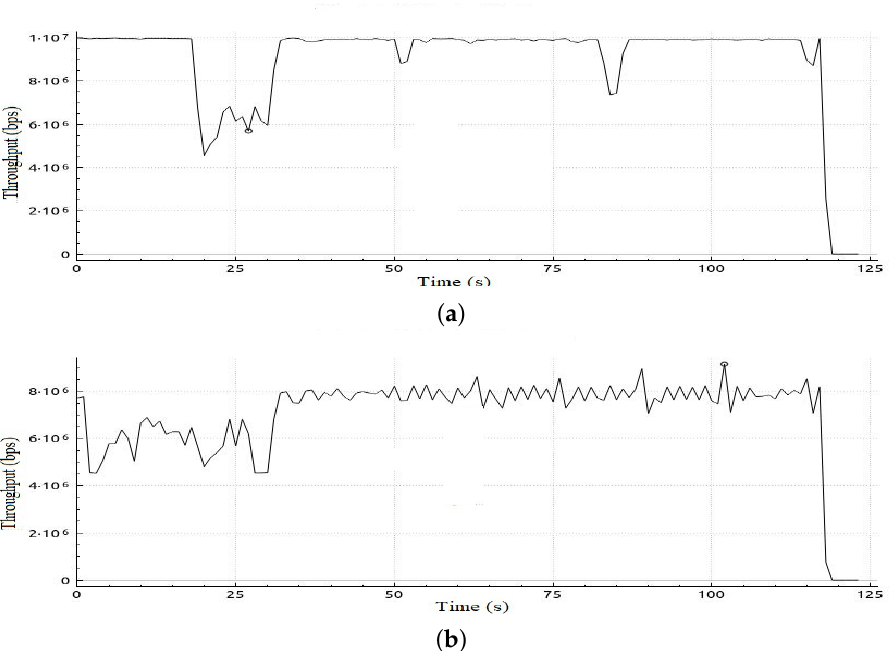
Figure 9. Throughput obtained in Scenario 1 in case of applying and without applying proposed adaptive QoS model for 120-seconds VoIP traffic flow ( a ) Throughput obtained in Scenario 1 in case of applying the proposed adaptive QoS model, ( b ) Throughput obtained in Scenario 1 without applying the proposed adaptive QoS model.